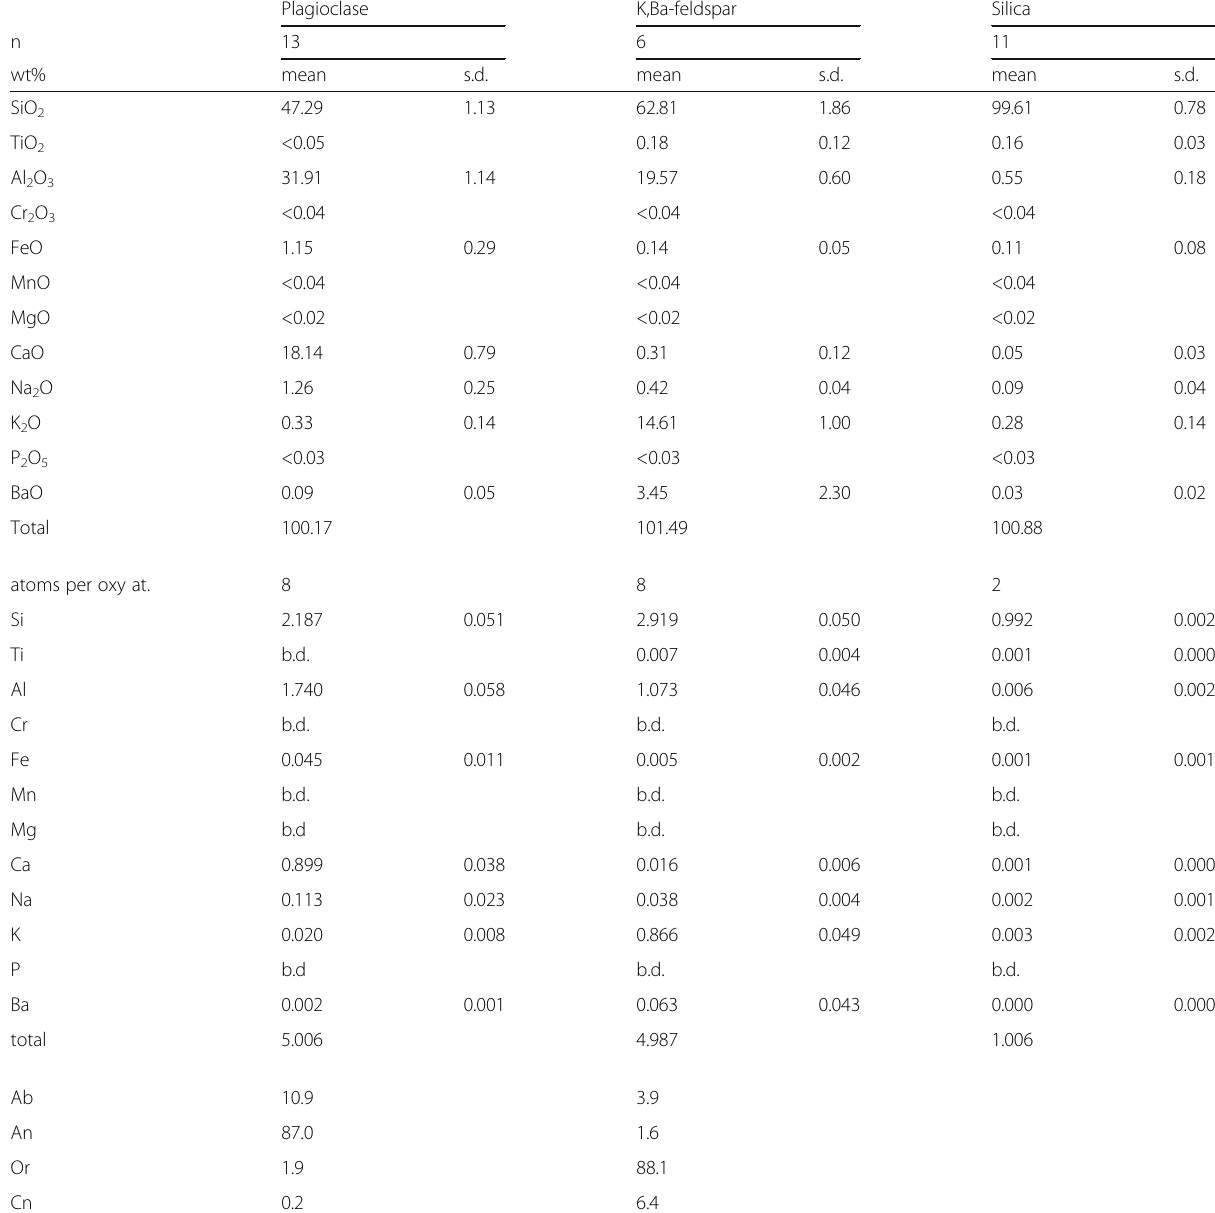
Table 3 Average compositions of plagioclase, K,Ba-feldspar and silica in the silicic clast Plagioclase K,Ba-feldspar